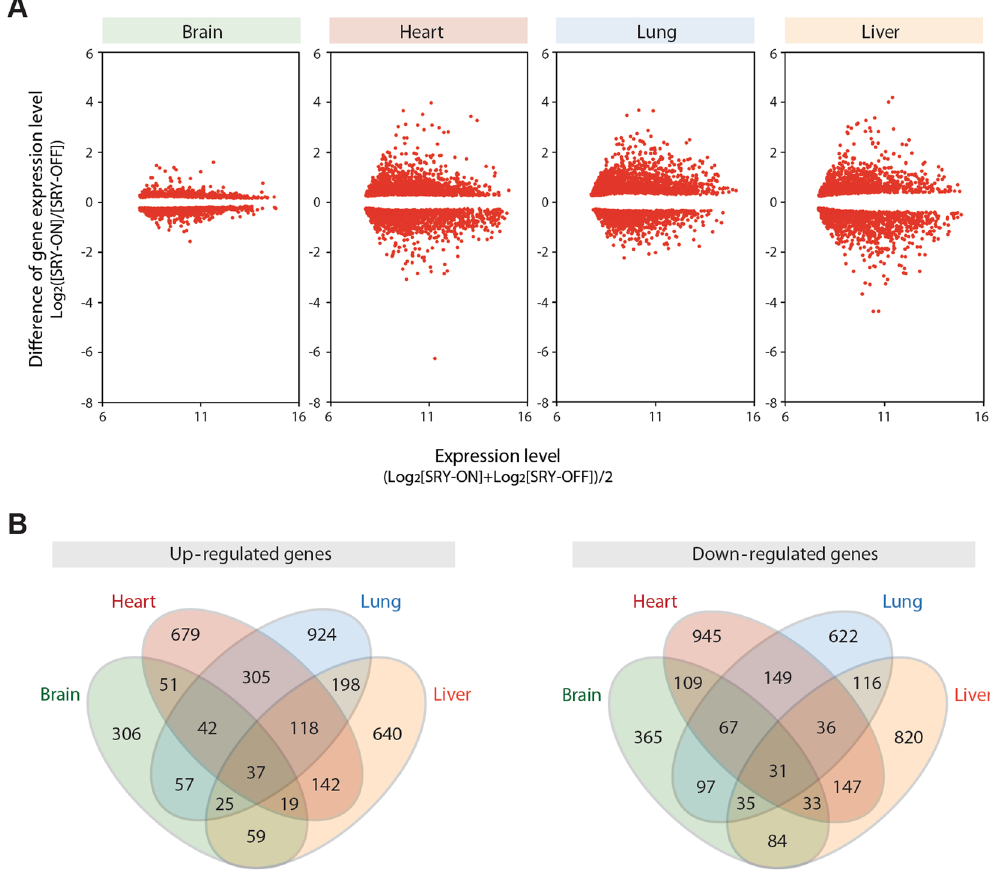
Figure 4. Differential gene expression patterns in brain, heart, lung and liver between hSRY-ON and control (hSRY-OFF) mice at P6 age, as revealed by transcriptome analysis. ( A ) MA plots showing differential gene expression patterns. ( B ) Venn diagrams showing extent of overlaps among differentially up regulated (left) and down regulated (right) genes among the 4 organs examined. See Supplemental Table S1 and S2 for gene